Question: How would you classify this visualization?
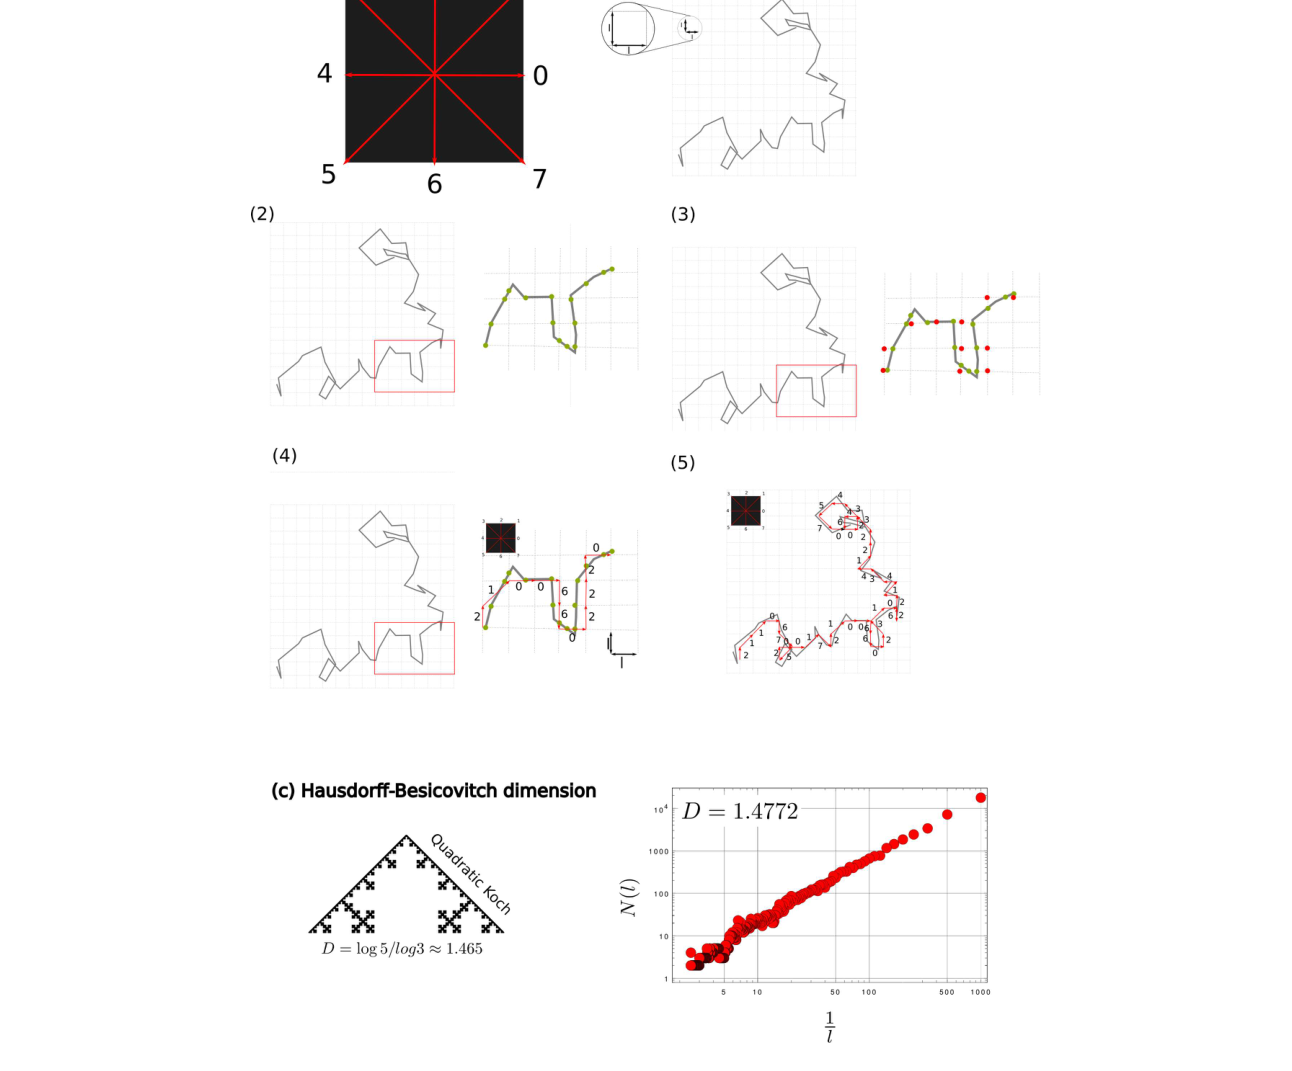
Answer: line